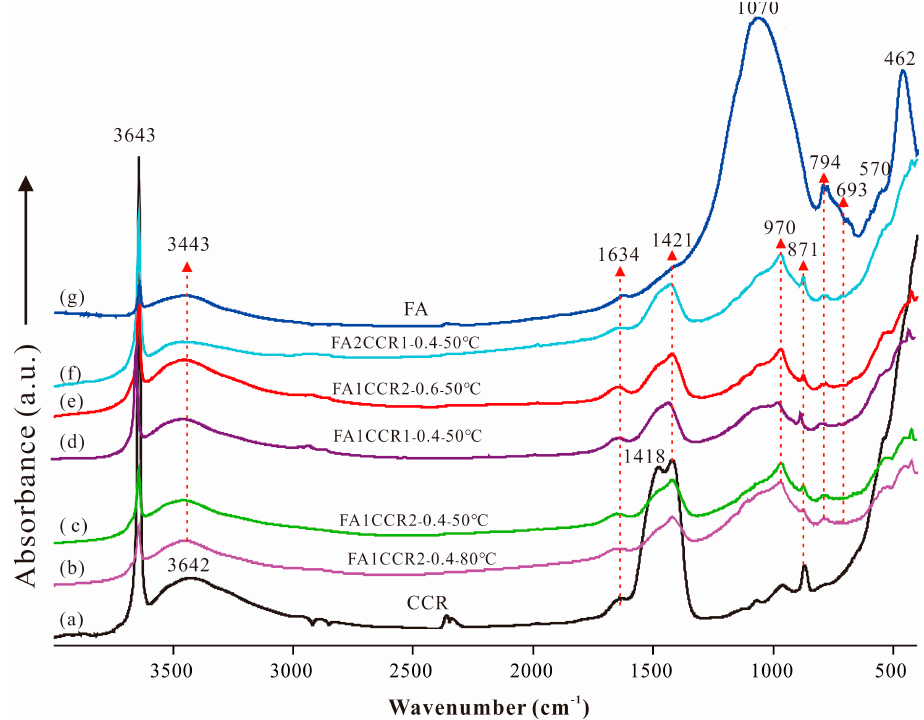
0.4-80 ◦ C; ( c ) FA1CCR2-0.4-50 ◦ C; ( d ) FA1CCR1-0.4-50 ◦ C; ( e ) FA1CCR2-0.6-50 ◦ C; ( f ) FA2CCR1-0.4-50 ◦ C; Figure 5. The FTIR spectra of raw materials and FA/CCR-based geopolymers. ( a ) CCR; ( b ) ( g ) FA1CCR2-0.4-80 °C; ( c ) FA1CCR2-0.4-50 °C; ( d ) FA1CCR1-0.4-50 °C; ( e ) FA1CCR2-0.6-50 °C; ( f ) FA2CCR1-0.4-50 °C; ( g ) FA.